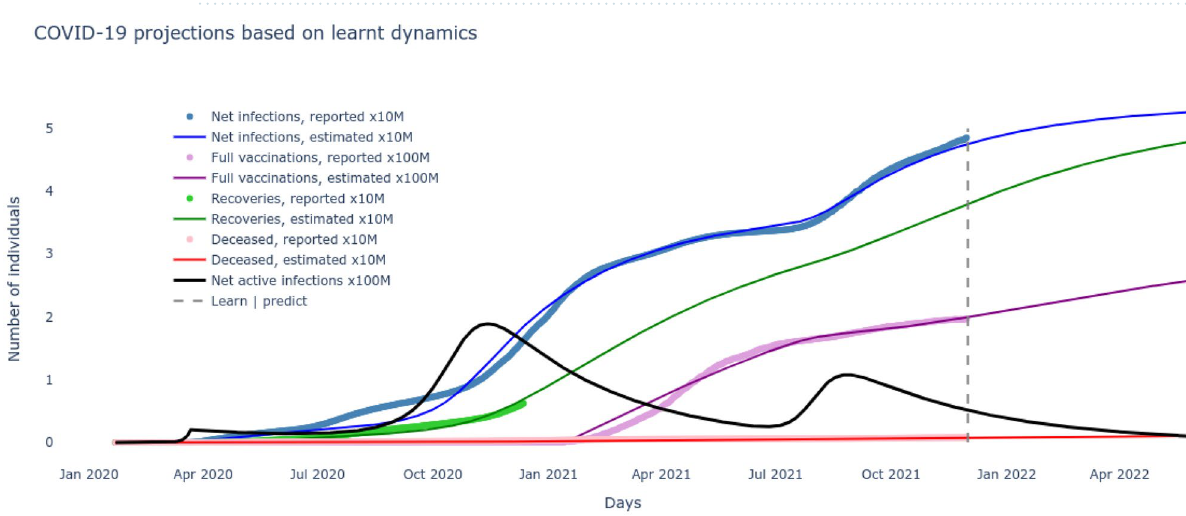
¯ β , v , β v , α f , τ , ρ , δ learned over